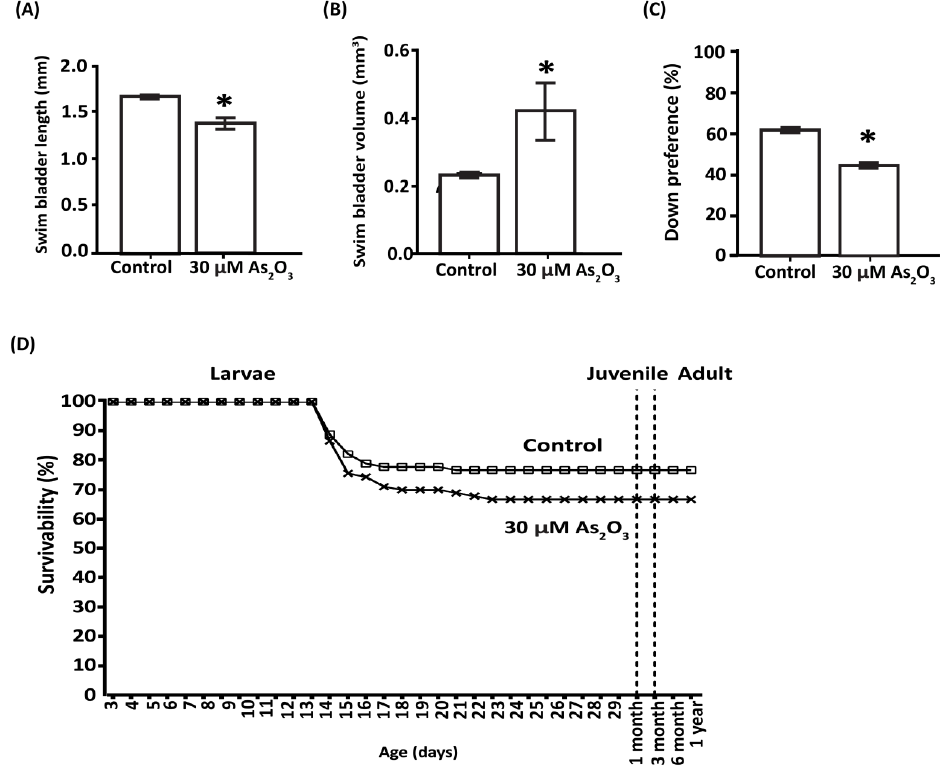
Figure 2. Effects of embryonic As 2 O 3 exposure in 6 dpf larvae and adult zebrafish . At 6 dpf, As 2 O 3 exposure increased swim bladder inflation/volume ( B ), although its anterior – posterior length was shortened ( A ). ( C ) With change in swim bladder volume, As 2 O 3 exposure also affected swimming behavior, with reduced down preference. ( D ) In adults, embryonic As 2 O 3 exposure resulted in a reduced percentage of survivability in As 2 O 3 exposed larvae (x), which was mainly detected at 13 – 23 dpf, compared to the control group ( □ ). Data are presented as mean ± SEM, ( ∗ p ≤ 0.05) n = 30 – 90 per group), with significant differences relative to the control group ∗ ( p ≤ 0.05).